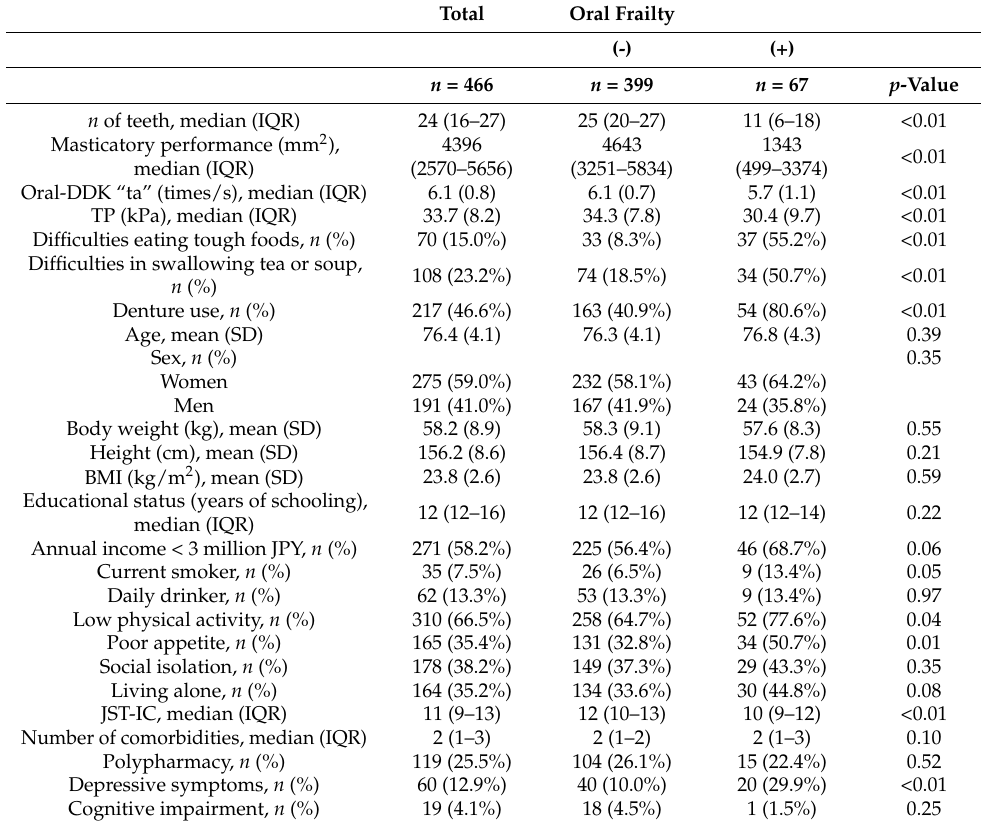
Table 2. Baseline characteristics of the study population according to the presence of oral frailty.